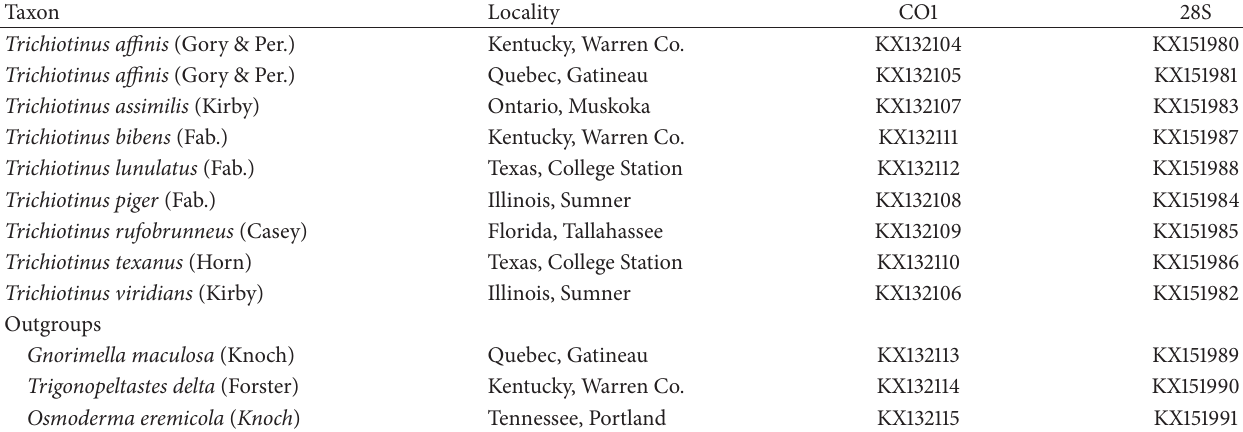
Table 1: List of taxa used in the analysis, their collection origin, and accession numbers for DNA sequences on GenBank. Taxon